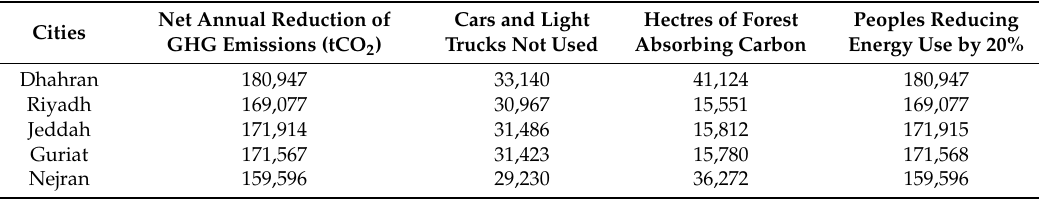
Table 5. Net annual reduction of GHG emissions for all sites.